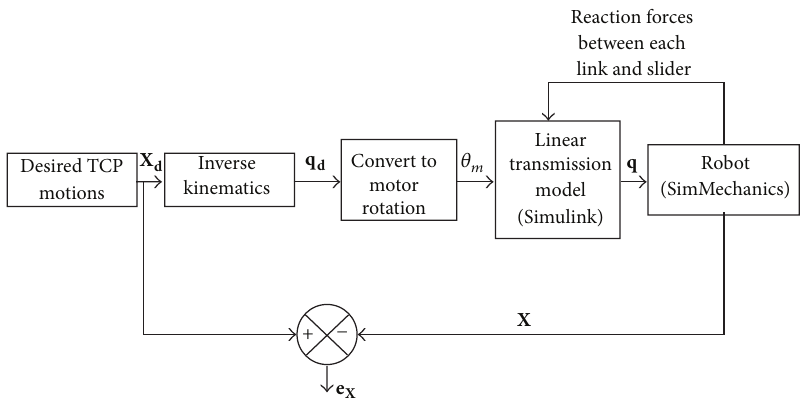
Figure 7: Block scheme to evaluate the error pose.